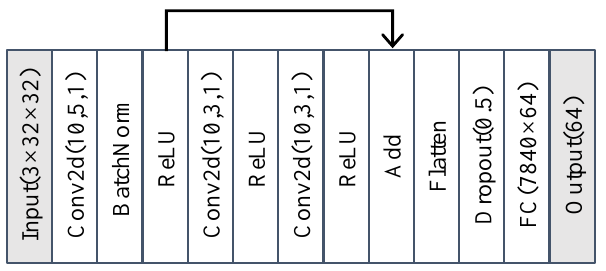
Figure 8. The confusion matrix of the different combinations. A S the unseen device. ( a ) Softmax+OvA; ( b ) AAMSoftmax+OvA; ( c ) Softmax+OpenMAX; ( d ) AAMSoft- max+OpenMAX.